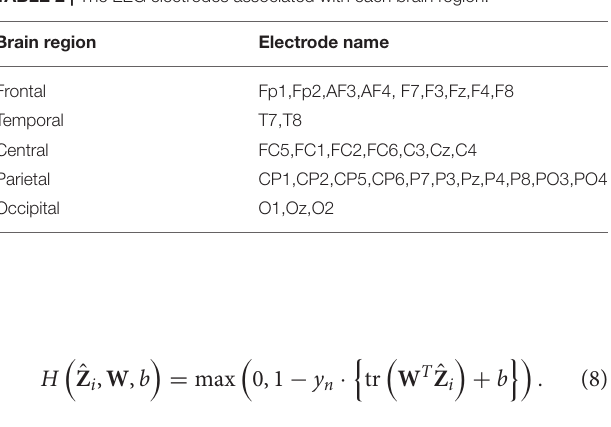
TABLE 2 | The EEG electrodes associated with each brain